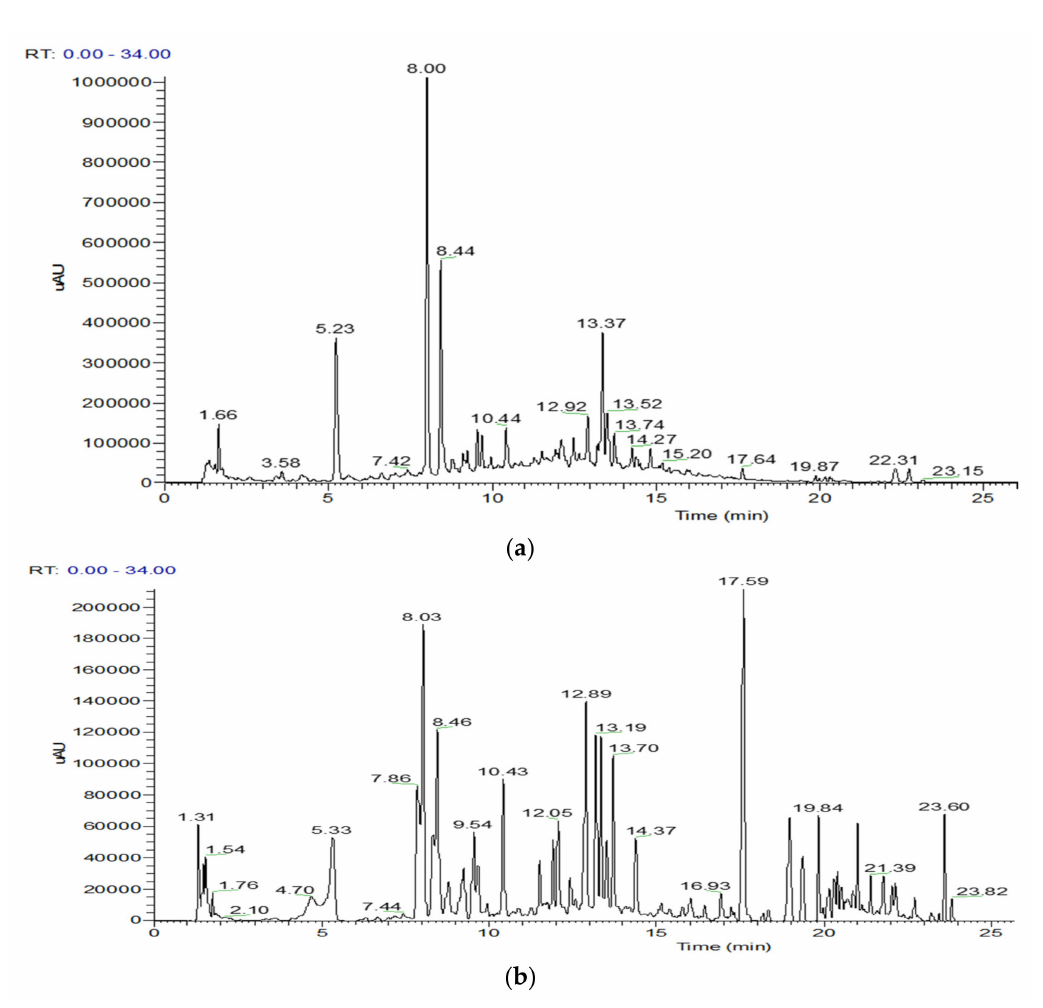
Figure 1. UHPLC chromatogram of the aqueous ( a ) and ethanolic ( b ) extracts of S. hispidula recorded at 280